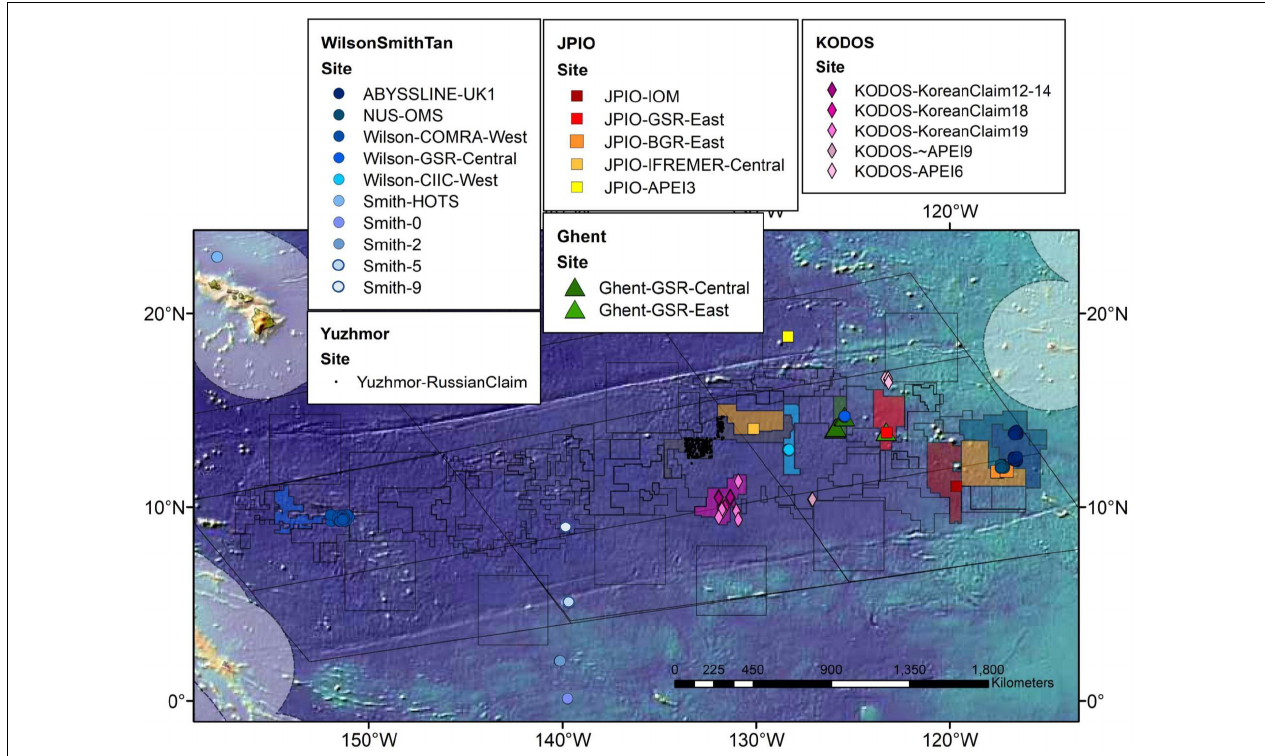
FIGURE 1 | Map of the CCZ showing study sites from which macrofaunal box-core data were assembled for use in this study. The characteristics of the data sets collected at these sites are presented in Tables 1 , 2 .